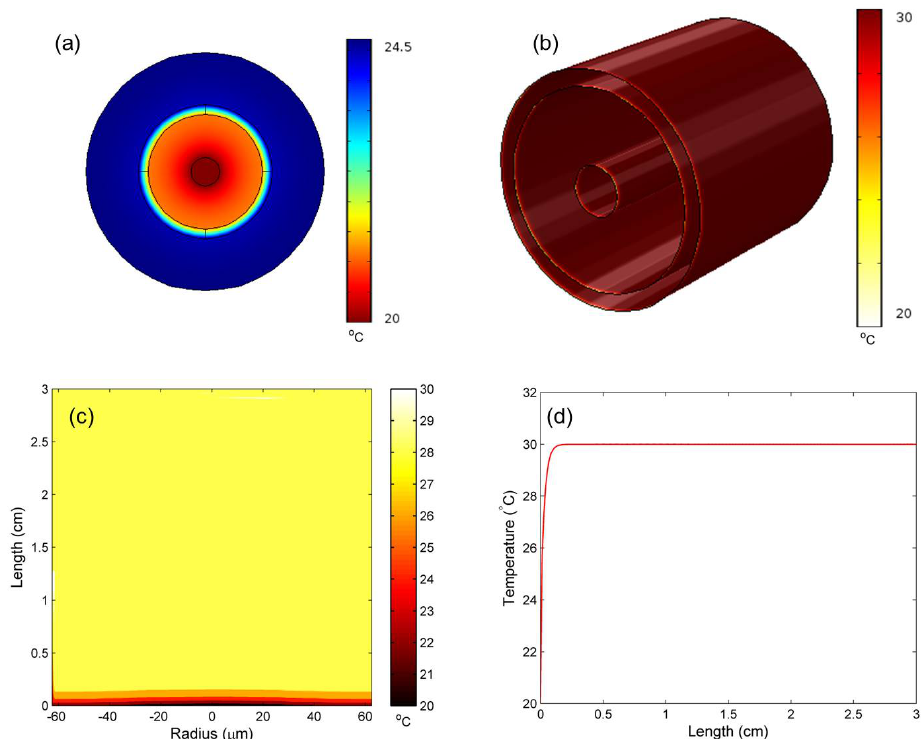
Figure 4. Typical steady-state results for the steady state of an MOF with a water channel radius of 10 µ m, with an external temperature of 30 ◦ C and an input velocity of 0.01 ms − 1 , with each label showing the ( a ) front fiber end surface temperature distribution; ( b ) 3D temperature distribution of the entire geometry; ( c ) cross-sectional temperature distribution and ( d ) temperature of the water channel vs. the length of the